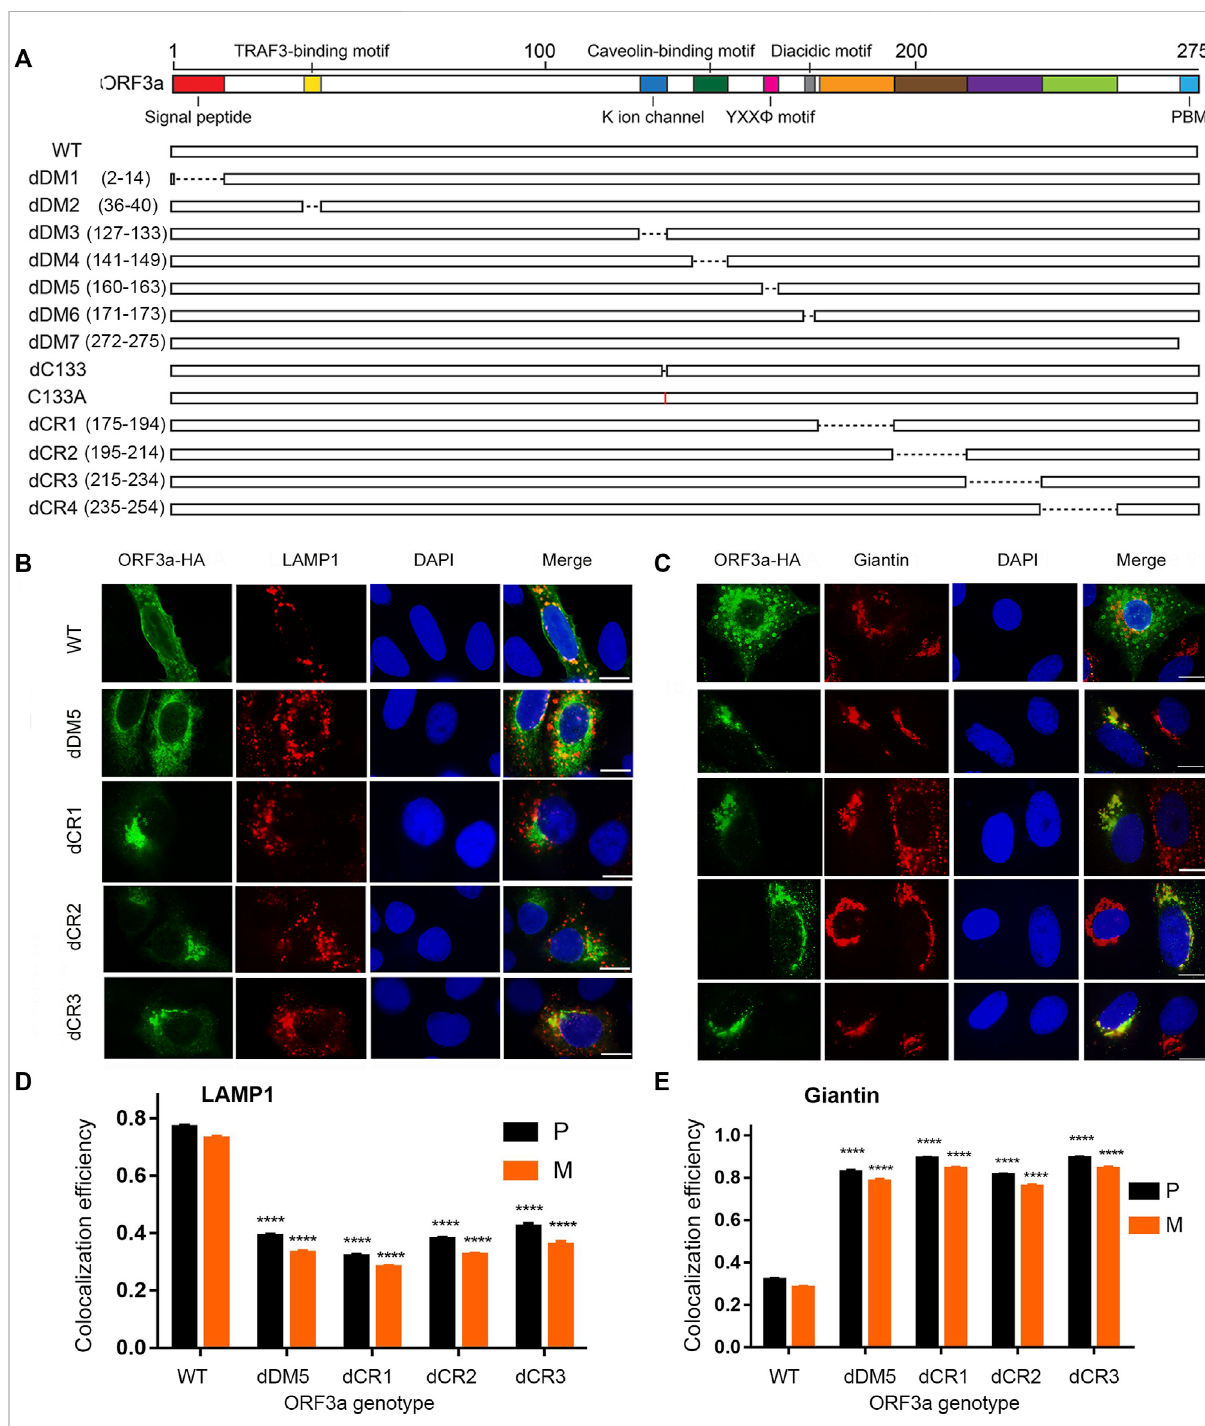
FIGURE 2 Mutagenesis of putative ORF3a functional and structural domains and corresponding changes of subcellular locations. (A) Schematic diagram showingwherethedeletionsandsingleaamutationsweremade.dDM1 — dDM7aredeletionsofputativefunctionaldomainmotifsbasedonprevious SARS-CoV and SARS-CoV-2 studies (Issa et al., 2020; Zhang et al., 2022b). dCR1 - dCR4, are deletions of presumably structural important cytoplasmic regions (CR) based on the bioinformatic analysis (this study). (B) Only those ORF3a mutants that showed different subcellular localizations from the WT are shown here. Those ORF3a mutants that show similar phenotypes to the WT are listed in Supplementary Figure S2. (C) ORF3a mutants show shift of subcellular localization from lysosomes to Golgi. A gene expression plasmid that carries a HA-tagged ORF3a at its C-terminalwasco-transfectedintoA549cellswithapRFP-LAMP1plasmid.Transfectedcellswerecollected24 hpt andwere fi xedfortheIFAtostain